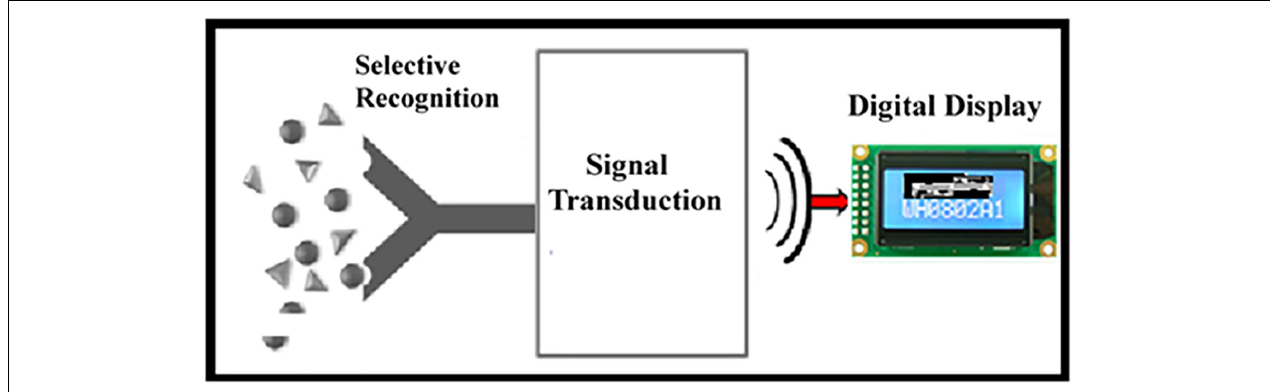
FIGURE 1 | Schematic diagram showing the main components of a biosensor. A “selective recognition” event allows specific interaction of the targeted analyte with the biocatalyst, resulting in a change in the sensing component. This process is followed by “signal transduction” into a “digital display” as a function of analyte